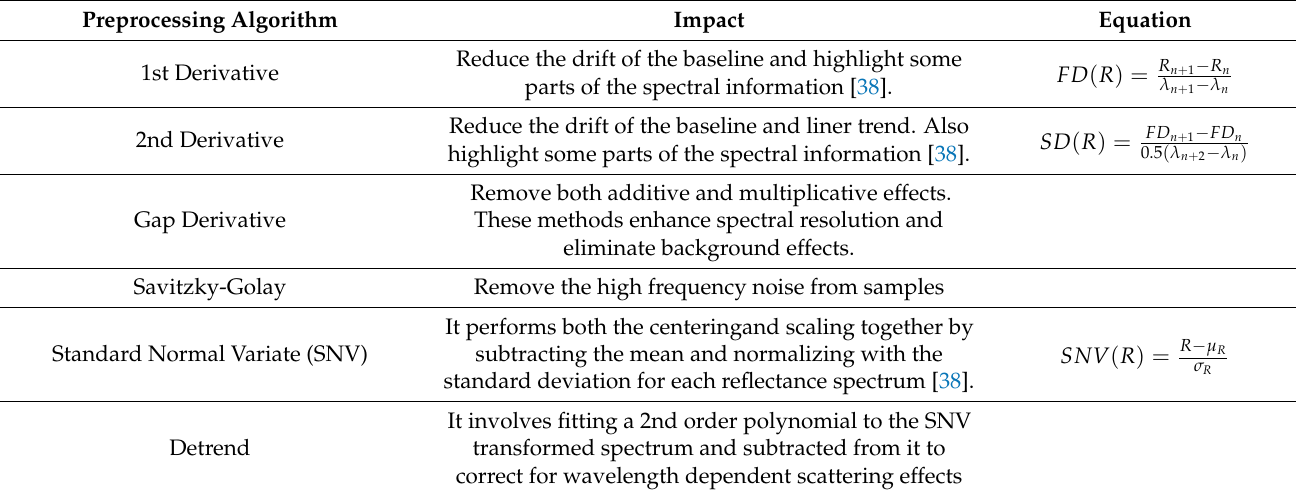
Table 2. Description of six preprocessing algorithms used in this study.